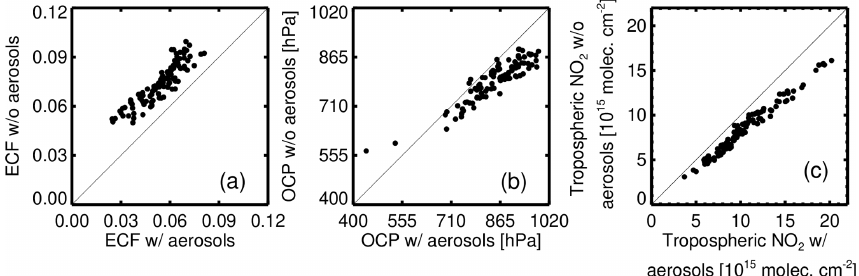
Figure 10. Scatter plots of retrieved quantities with implicit aerosol correction versus those retrieved with explicit aerosol correction for the selected area in OMI orbit 3843 on 5 April 2005. (a) Effective cloud fraction at 466nm (ECF 466 ), (b) cloud optical centroid pressure (OCP), and (c) tropospheric NO 2 vertical column